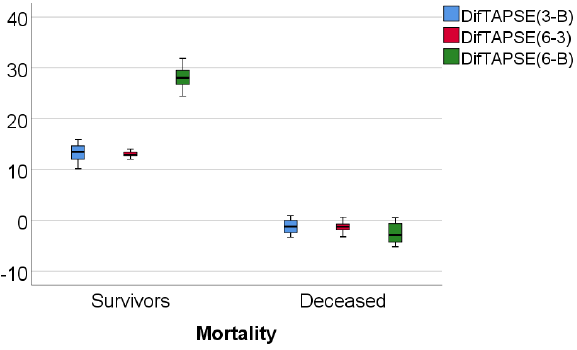
Figure 6. Box-plot representation of TAPSE evolution in comparison with mortality.